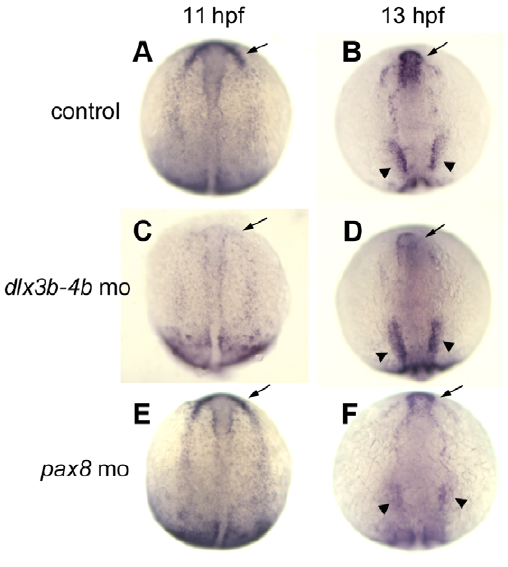
Figure 9. Differential spatial regulation of itga5 by dlx 3b/ 4b and pax8 . ( A–F ) itga5 expression at 11 hpf and 13 hpf in control embryos (A, B), dlx3b-dlx4b double morphants at (C, D), and pax8 morphants (E, F). Regions where expression normally upregulates in precursors of anterior placodes (arrows) and otic/epibranchial precursors (arrow- heads) are indicated. Images show dorsal views with anterior to the